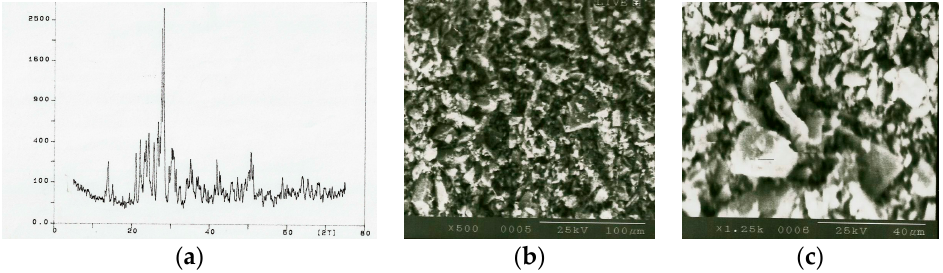
Figure 4. Finnish flotation feldspar (FFF) material sample: ( a ) X-ray diffraction pattern for 2 θ angles showing arbitrary counts (counts) versus 2 θ angles (2T) in degrees; ( b ) Scanning electron micrograph at 500× magnification; and ( c ) Scanning electron micrograph at 1250× magnification.